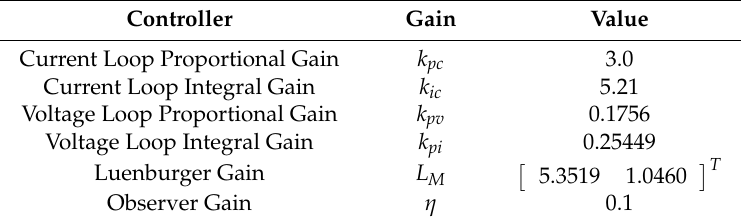
Table 2. Optimal gains for a proportional-integral (PI) and a dead-beat (DB) predictive controller. Controller Gain Value Current Loop Proportional Gain k pc 3.0 Current Loop Integral Gain k ic 5.21 Voltage Loop Proportional Gain k pv